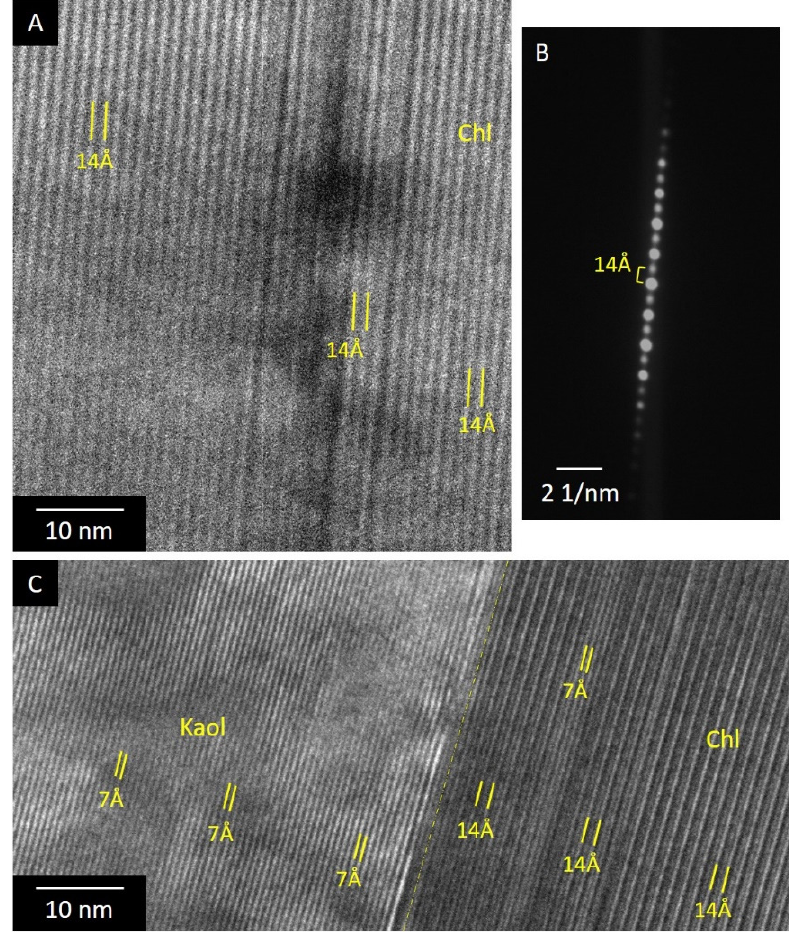
Figure 13. TEM images obtained on the FIB section. ( A ): high-resolution image of the chlorite formed at the vein/shale interface. ( B ): electron diffraction obtained on the area of A; 00 l spots. ( C ): high-resolution of a kaolinite/chlorite contact. Kaol: kaolinite; Chl: chlorite. Table 2. TEM-EDX analyses of kaolinite. Apfu; 7 oxygen basis.